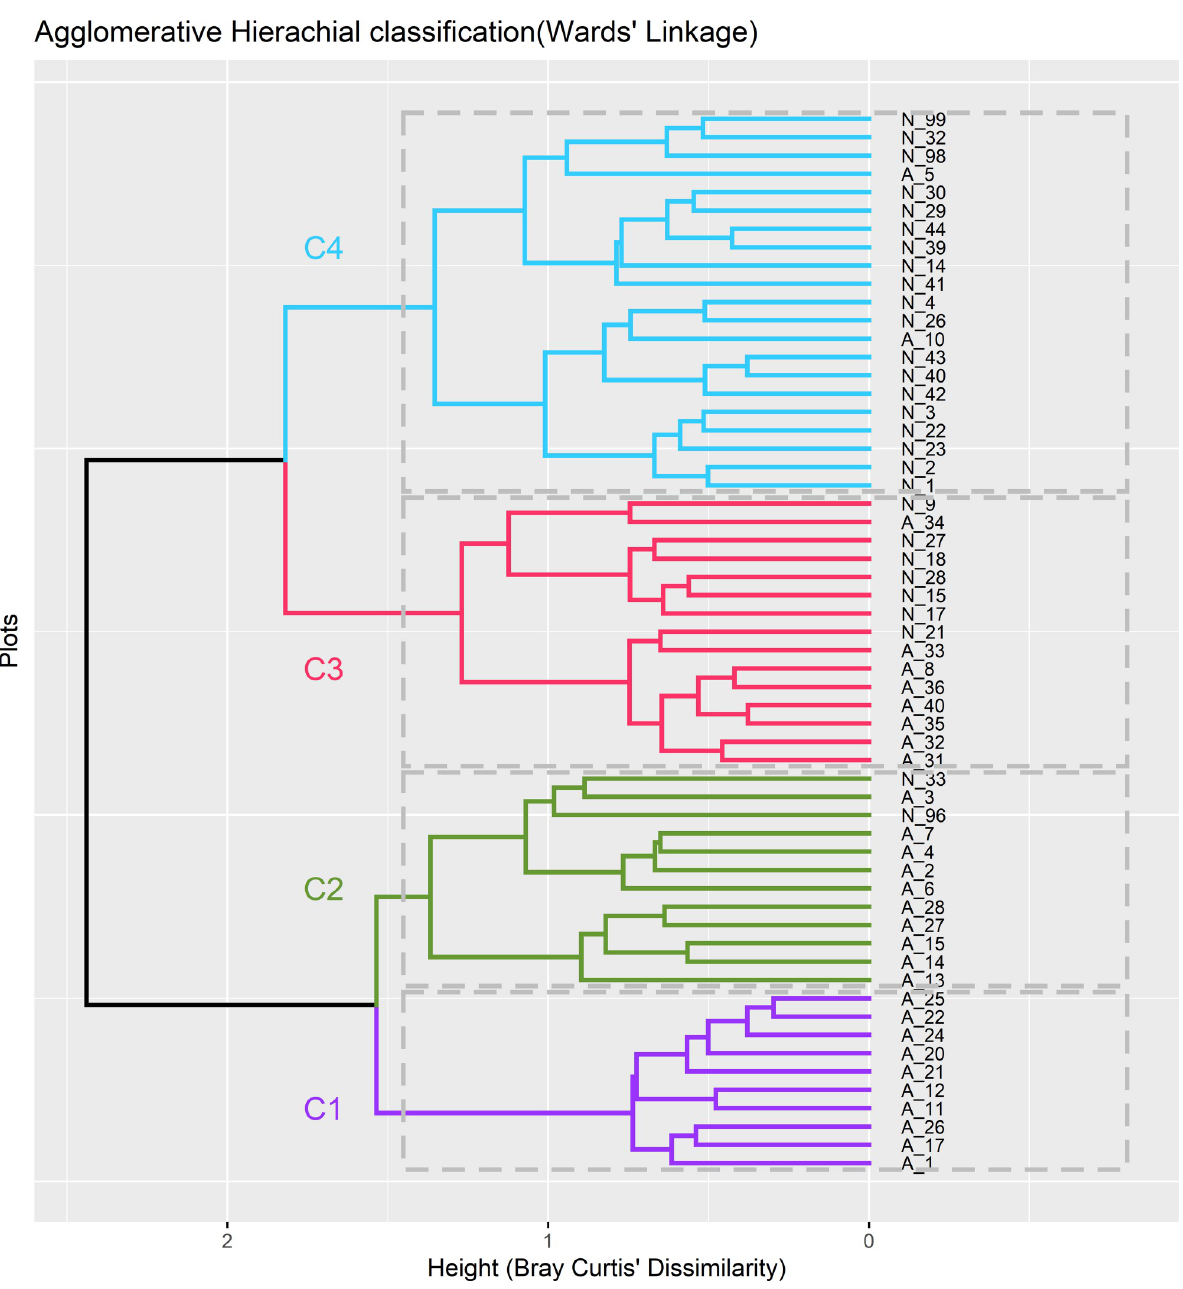
Fig 3. Dendrogram of hierarchical clustering using similarity ratio showing four community types in different sites (plot 1–59) of the study area (Ward’s method, Bray-Curtis distance) across Amani and Nilo nature forest reserve in sub-tropical East Usambara montane forest of Eastern Arc. The communities are named by using number of communities denoted as (Cn) and they are named after by two dominant species: C1 = Tabernaemontana ventricosa-Leptonychia usambarensis , C 2 = Ficus sur- Myrianthus holstii , C3 = Artocarpus heterophyllus-Lecaniodiscus fraxinifolia and C4 = Isoberlinia schefflera- Sorindeia madagascariensis communities (S1 Appendix).